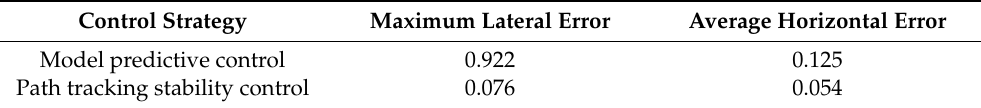
Table 7. Tracking error comparison.